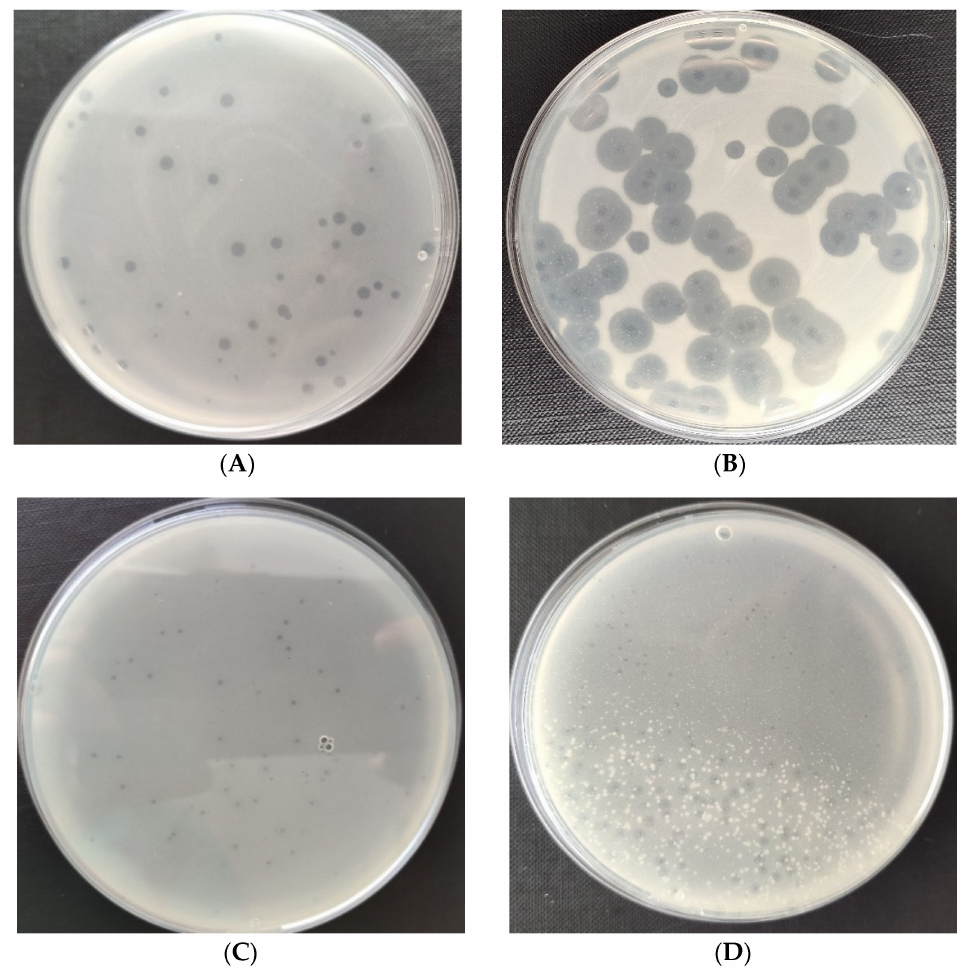
Figure 1. Plaques of specific phages against the bacterial hosts: ( A ) Enterobacter phage KKP 3262; ( B ) Serratia phage KKP 3708; ( C ) Enterobacter phage KKP 3711; ( D ) Serratia phage KKP